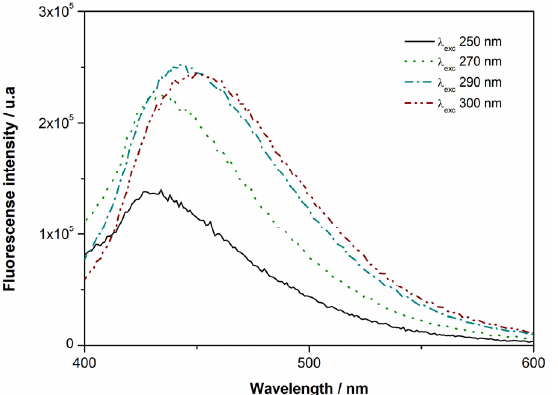
Figure 9. UV/Vis spectra of A(170)_ 3a @1000 and A(170)_ 3b @1000 OIH matrices normalized to the